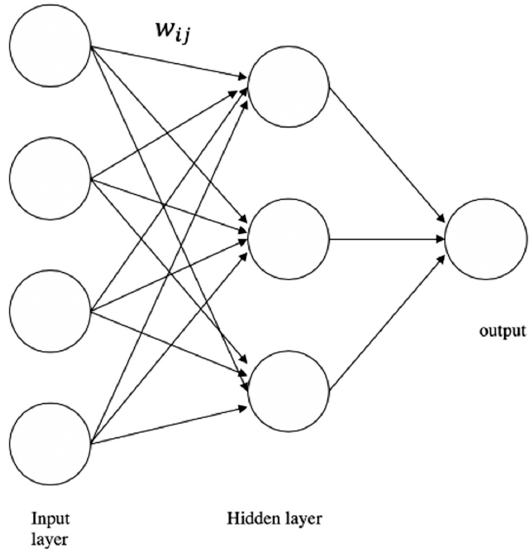
Figure 2. The mechanism of a neural network.